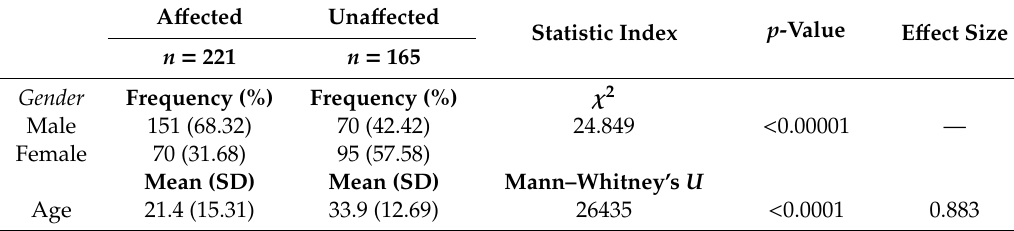
Table 1. Demographic characteristics of individuals included in this study. Una ff ected individuals were also ascertained from the 113 nuclear families but are clinically undiagnosed with ADHD. A ff ected Una ff ected Statistic Index p -Value E ff ect